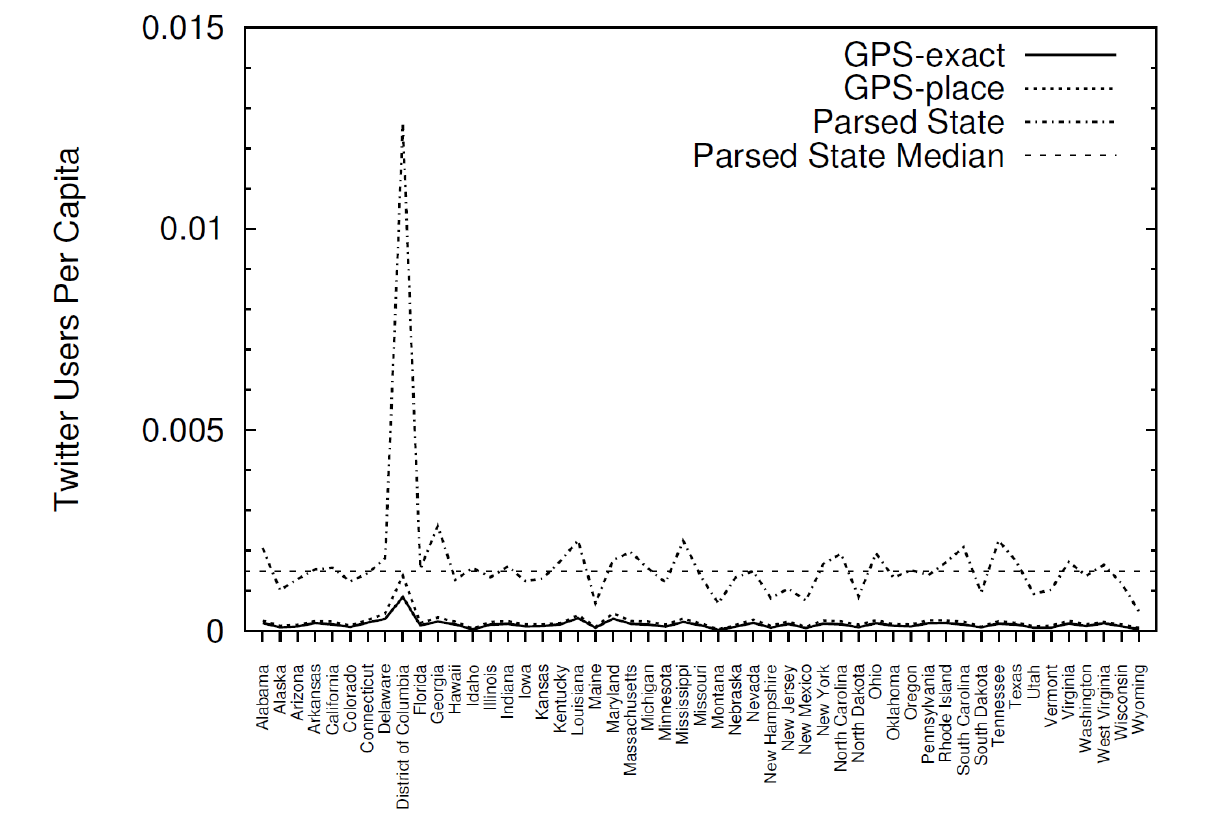
Figure 4. The number of geolocated Twitter users per capita in each